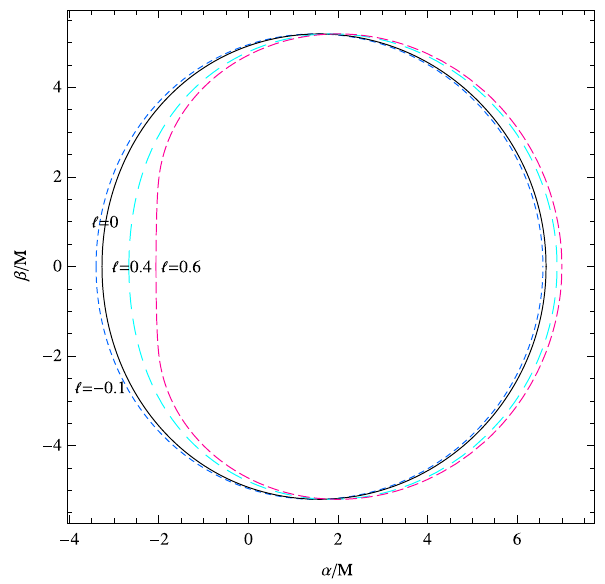
Fig. 2 The shapes of the shadow with a / M = 0 . 79 , θ = π/ 2. The black solid line is for Kerr black hole